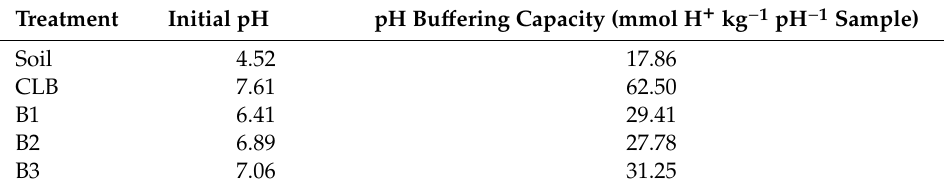
Table 21. E ff ects of treatments on initial suspension pH and pH bu ff ering